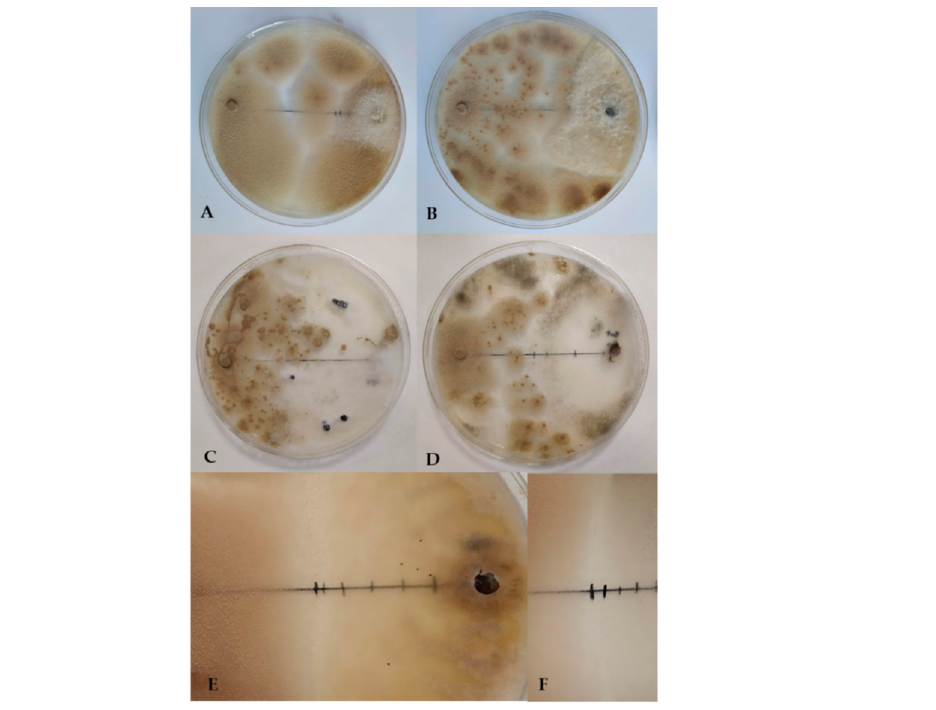
Figure 4. In vitro antagonistic effects of P. variotii on F. solani ( A ), M. melonis ( B ), S. sclerotiorum ( C ), and B. cinerea ( D ) in 9 cm Petri dishes. Inhibition zone between P. variotii and the phytopathogens M. melonis ( E ) and F. solani ( F ) (Images 75% increased).